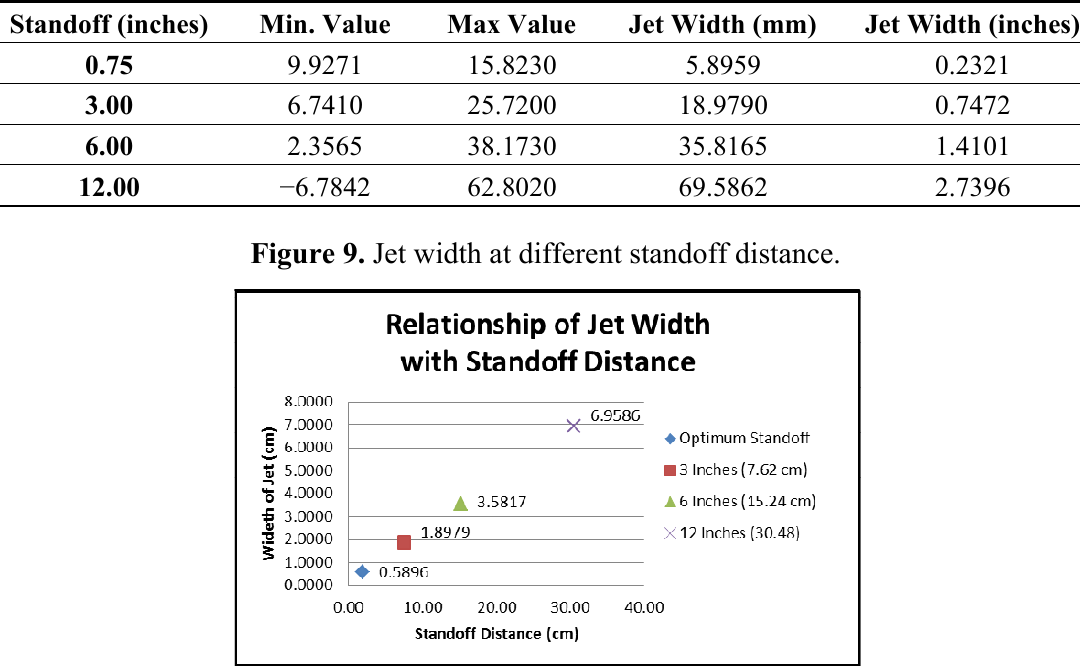
Table 2. Jet width under different standoff distances.